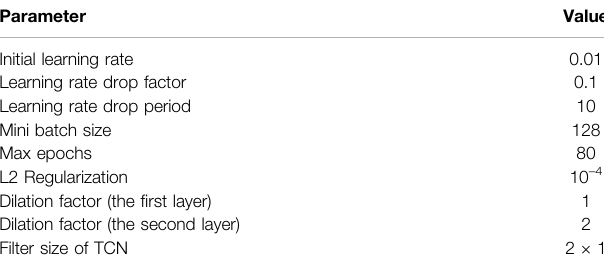
TABLE 1 | Hyperparameters of